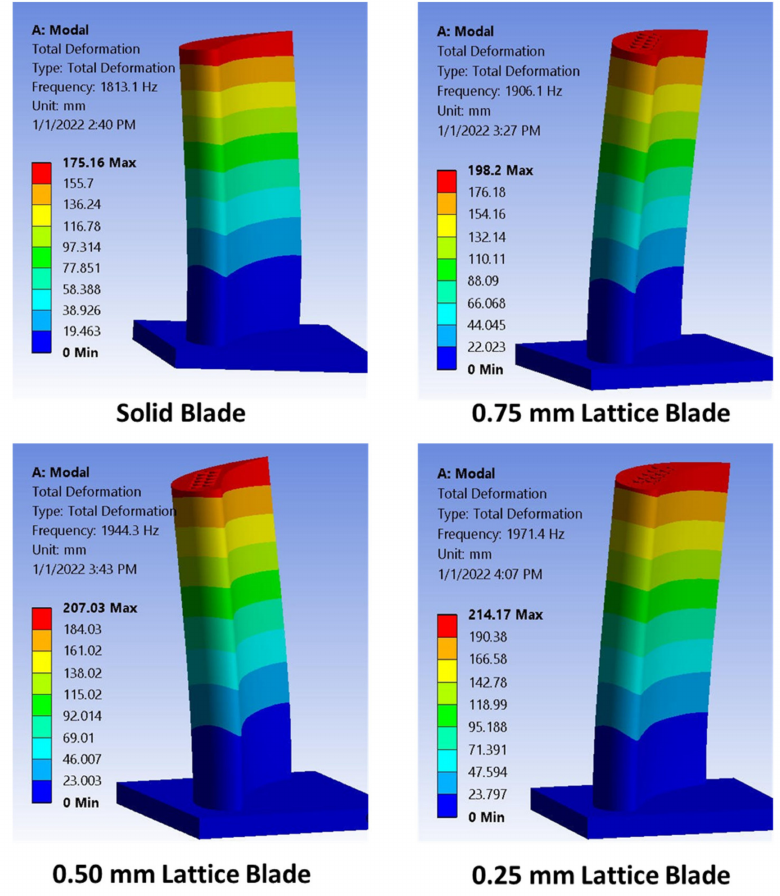
Figure 8. Mode shapes of turbine blades at the first natural frequency.